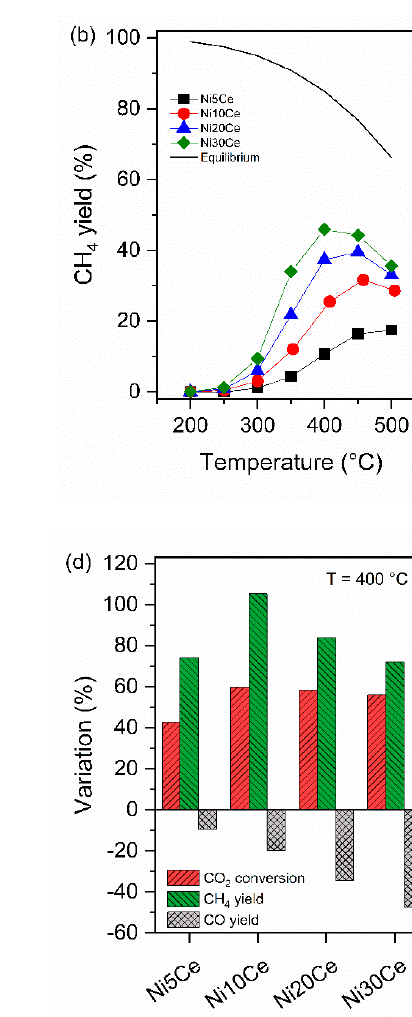
Catalysts 2019 , 9 , x FOR PEER REVIEW